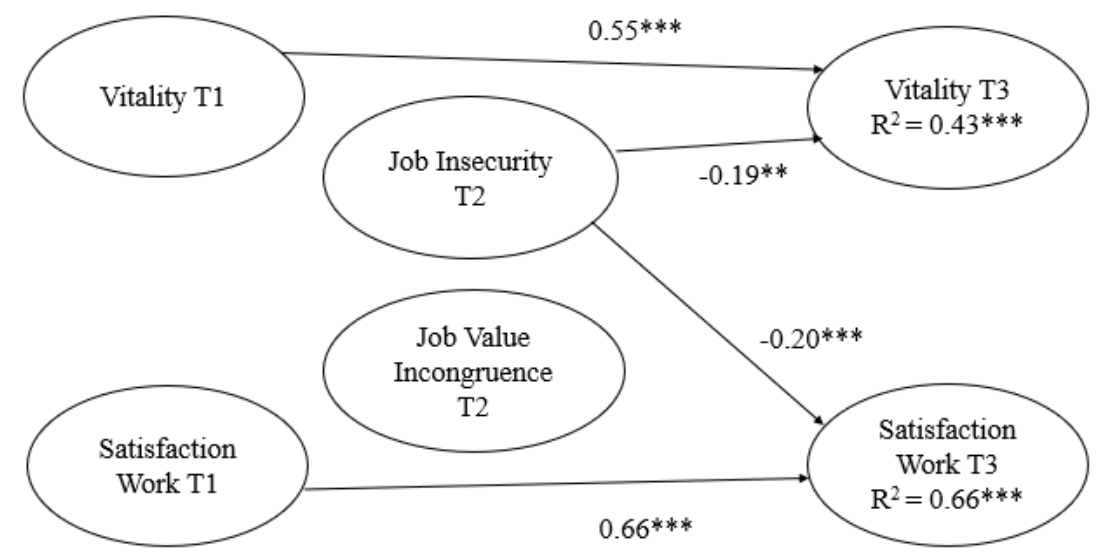
Figure 1. Job insecurity and job value incongruence at work predicting psychological well-being. N = 299. Model fit: χ 2 (333) = 767.33, p = 0.000, CFI = 0.91, TLI = 0.90, RMSEA = 0.07 (90% CI 0.06–0.07), SRMR = 0.05; * p < 0.05, ** p < 0.01, *** p < 0.001.